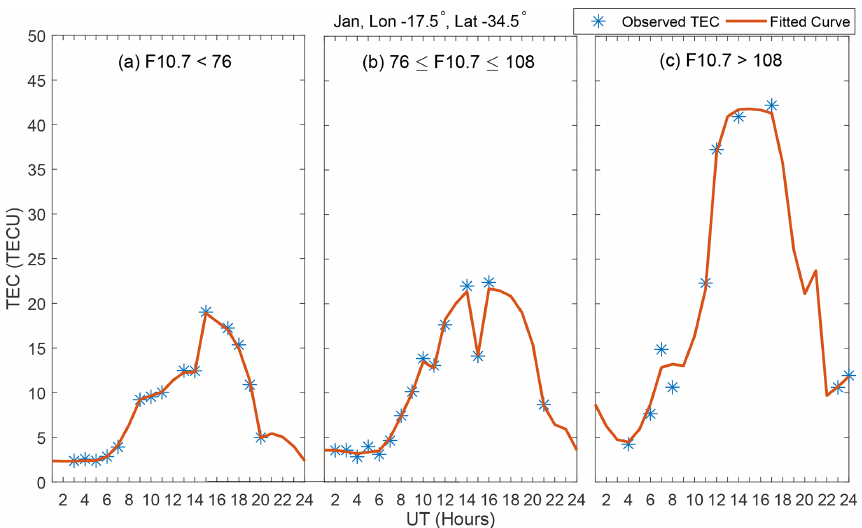
Figure 1. Panels (a–c) present available ( ∗ ) and estimated (red line) TEC values during low, medium and high solar flux levels, respectively. The data are for the month of January and fall within the grid cell centered at longitude and latitude of 17.5 ◦ W and 34.5 ◦ S, respectively.